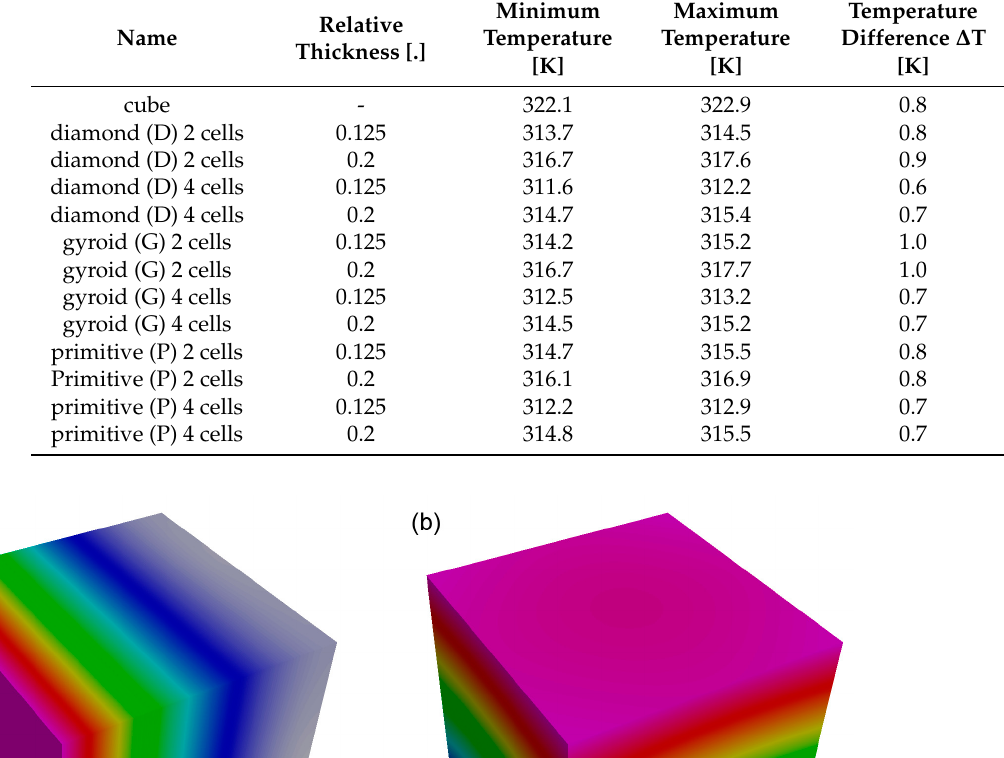
Table 3. Maximum, minimum, and temperature difference from heat transfer simulation.